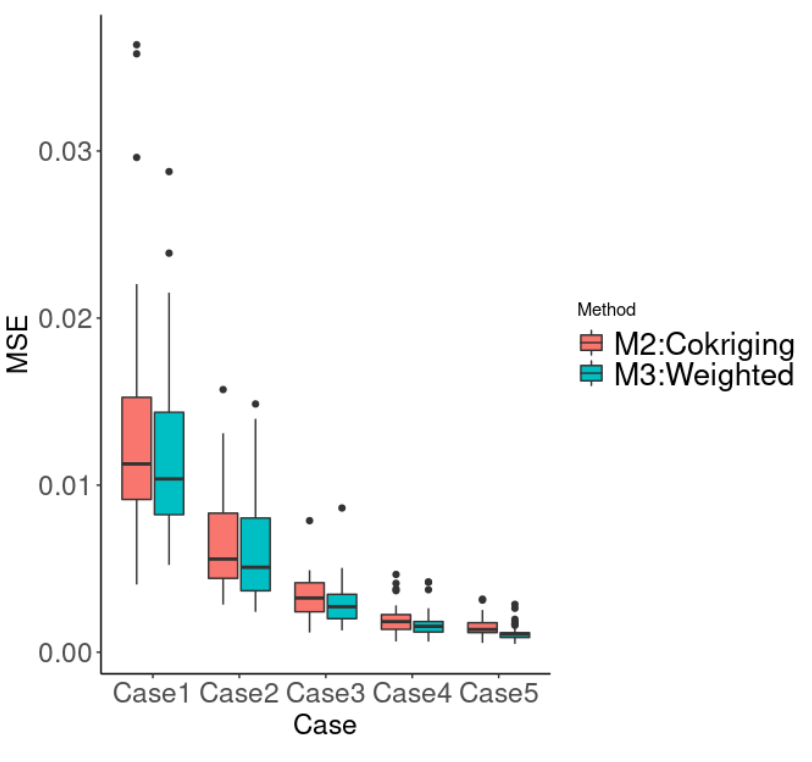
Figure 5. The MSE of our two proposed methods.